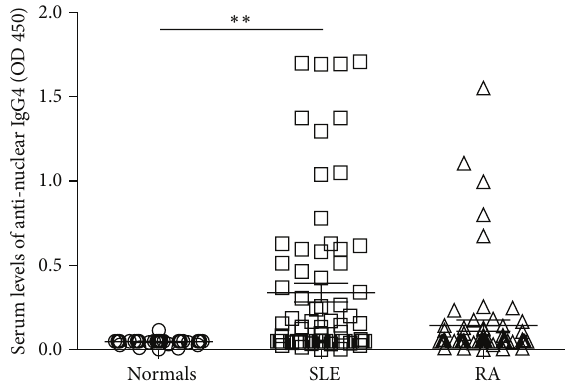
Figure 1: Comparison of serum levels of anti-nuclear IgG4 in various groups. Detection of serum levels of anti-nuclear IgG4 in the serum of normals and SLE and RA patients was conducted using a molecular biology kit as described in Section 2 (normal = 41, SLE = 72, and RA = 67; ∗∗ 𝑃 < 0.01